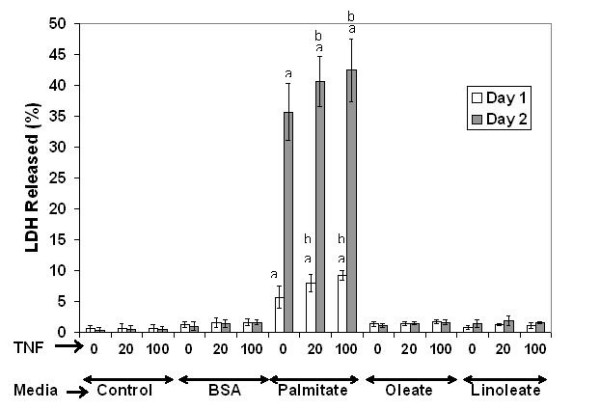
Cytotoxicity (LDH release). Confluent HepG2 cells exposed to different types of fatty acids (0.7 mM, complexed to 4% w/v BSA) and TNF-α for 24 and 48 hours. X-axis labels indicate the TNF-α concentration in ng/ml and the medium employed in each condition. Data expressed as averages of nine samples +/- s.d. from three independent experiments. a, Significant medium effect, P < 0.05 relative to control (BSA medium with no TNF-α); b, Significant TNF-α effect within a treatment, P < 0.05 compared to corresponding medium with no TNF-α exposure. TNF-α concentrations are in ng/ml.